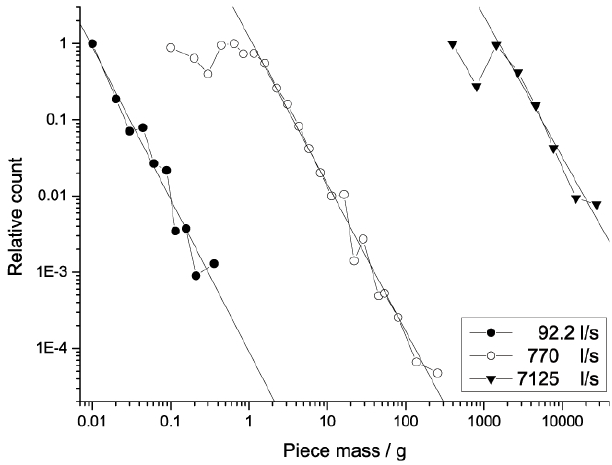
Figure 3. Examples of histograms of CPOM particle masses at three di ff erent discharges, spanning two orders of magnitude in dis- charge and more than six orders of magnitude in particle mass. To reduce the extent of the axes, and to demonstrate the general simi- larity of the CPOM piece count vs. mass relations, each of the his- tograms was normalized such that the most common fraction plots at a relative count of one. The sample collected at 92.2Ls − 1 is typ- ical of those taken with bedload traps, the one at 770Ls − 1 of those with basket samplers, and the one at 7125Ls − 1 was collected from the debris basin.